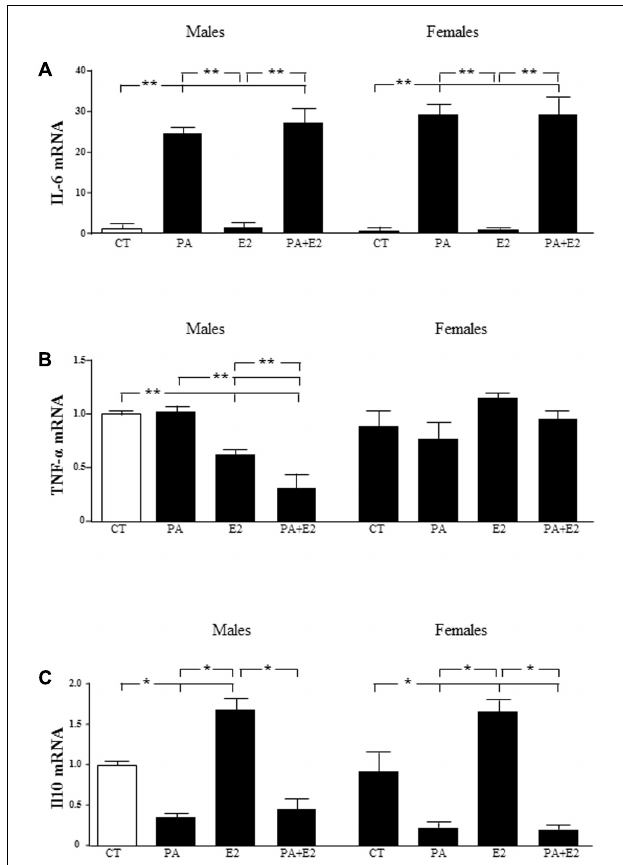
FIGURE 7 | Effects of PA and 17 β E2 on cytokine mRNA levels. Astrocyte cultures were treated with PA (0.5 mM), E2 (10 − 10 M), or the combination of both. Relative mRNA levels of IL-6 in males and females (A) ; tumor necrosis factor α (TNF α ) in males and females (B) and IL-10 in males and females (C) were measured. The average of three independent assays performed in duplicate is shown. Statistical significance: ∗ p < 0.05 and ∗∗ p <